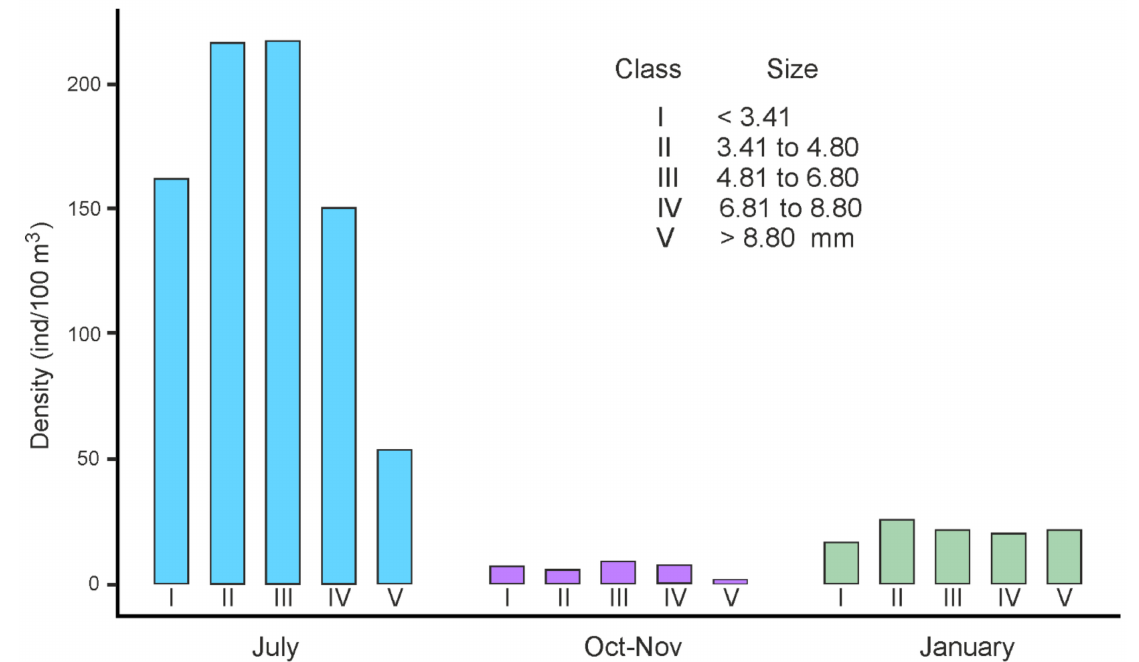
Figure 7. Size structure of the Belzebub faxoni population throughout three sampling seasons.